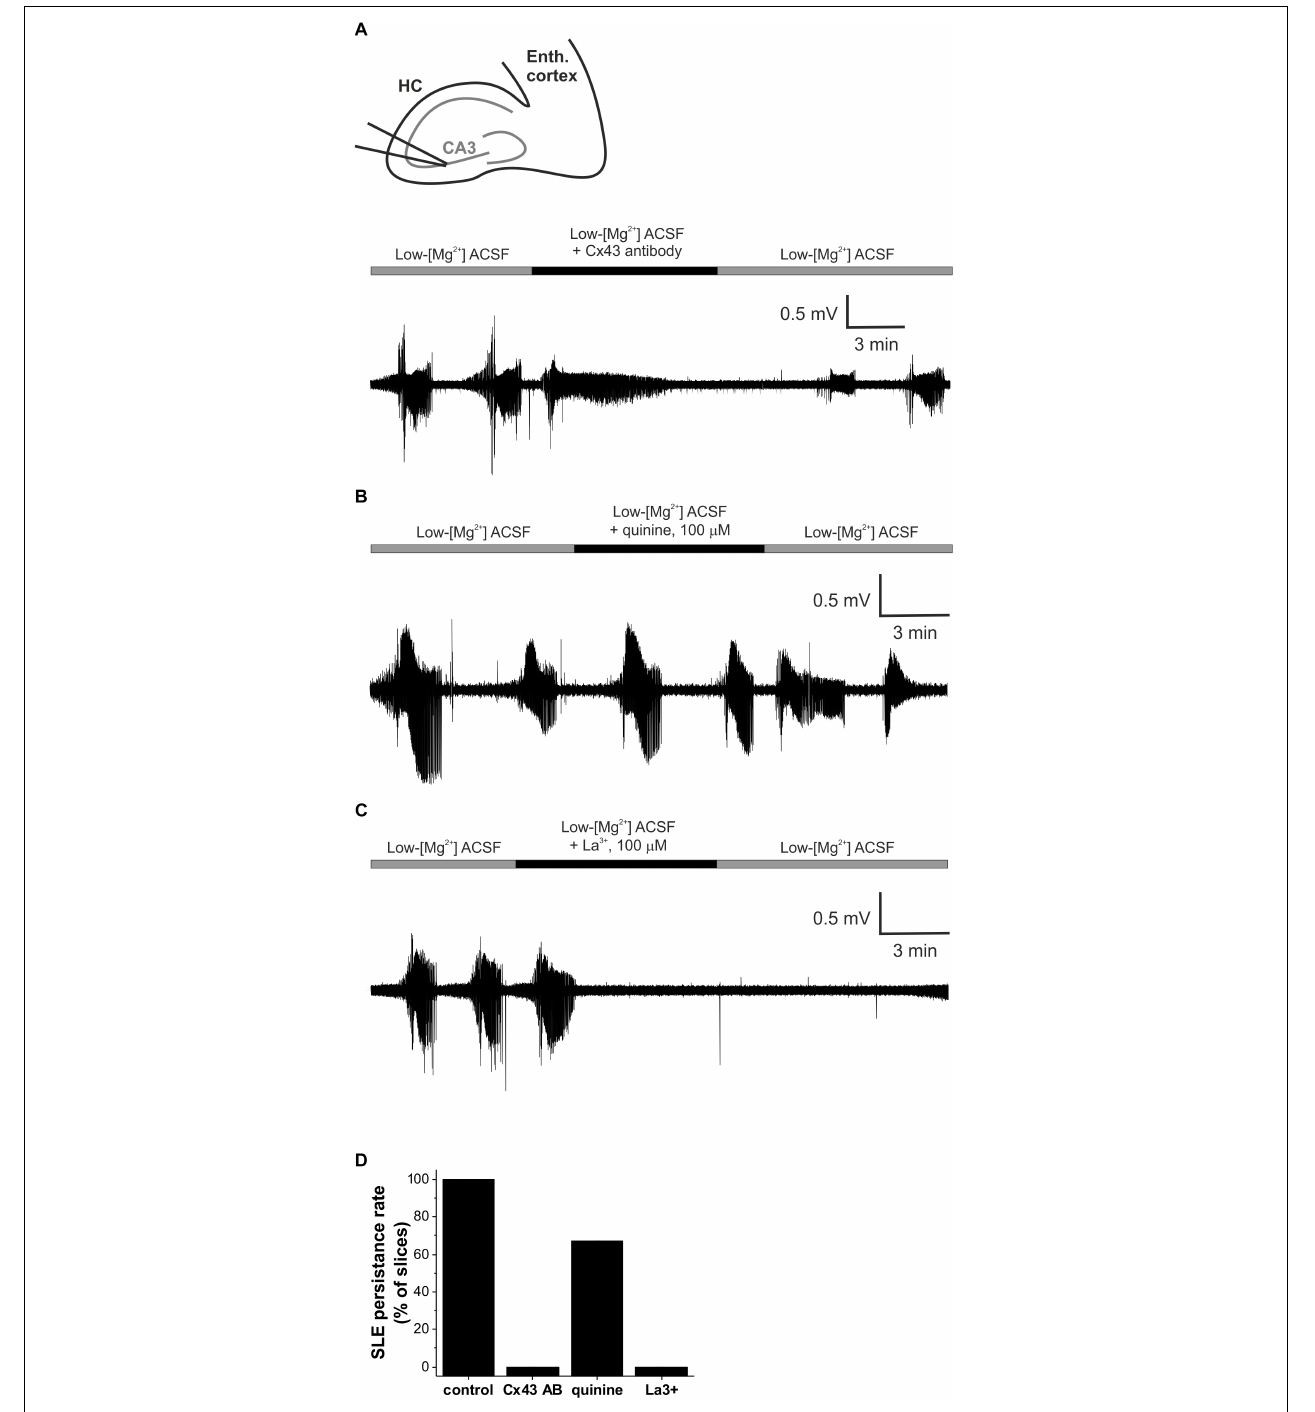
FIGURE 2 | Gap junctional control over epileptiform activity is mediated specifically by the astrocytic gap junctions in vitro in the low-[Mg 2 + ] TLE model. (A) Representative extracellular field potential (FP) recording of recurrent seizure-like events (SLEs) under control conditions and in the presence of a Cx43-specific antibody specifically blocking astrocytic connexin channels in the CA3 region of a hippocampal slice. (B) Representative extracellular FP recording of recurrent SLEs under control conditions and in the presence of the Cx36-specific quinine specifically blocking neuronal connexin channels in the CA3 region of a hippocampal slice. (C) Representative extracellular FP recording of recurrent SLEs under control conditions and in the presence of the hemichannel-specific La(NO 3 ) 3 in the CA3 region of a hippocampal slice. (D) Percentage of slices in which SLEs persisted in the presence of gap junction inhibitors applied after two fully developed SLEs in low-[Mg 2 + ] ACSF. SLEs were considered to be persisted if at least two SLEs appeared during the application of the given inhibitor.